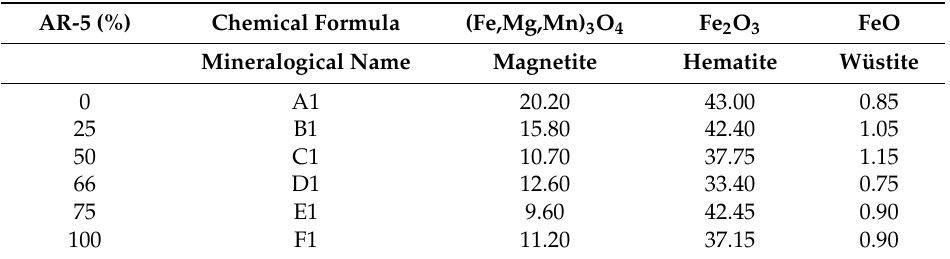
Table 7. The phase composition of produced agglomerates—iron oxides.